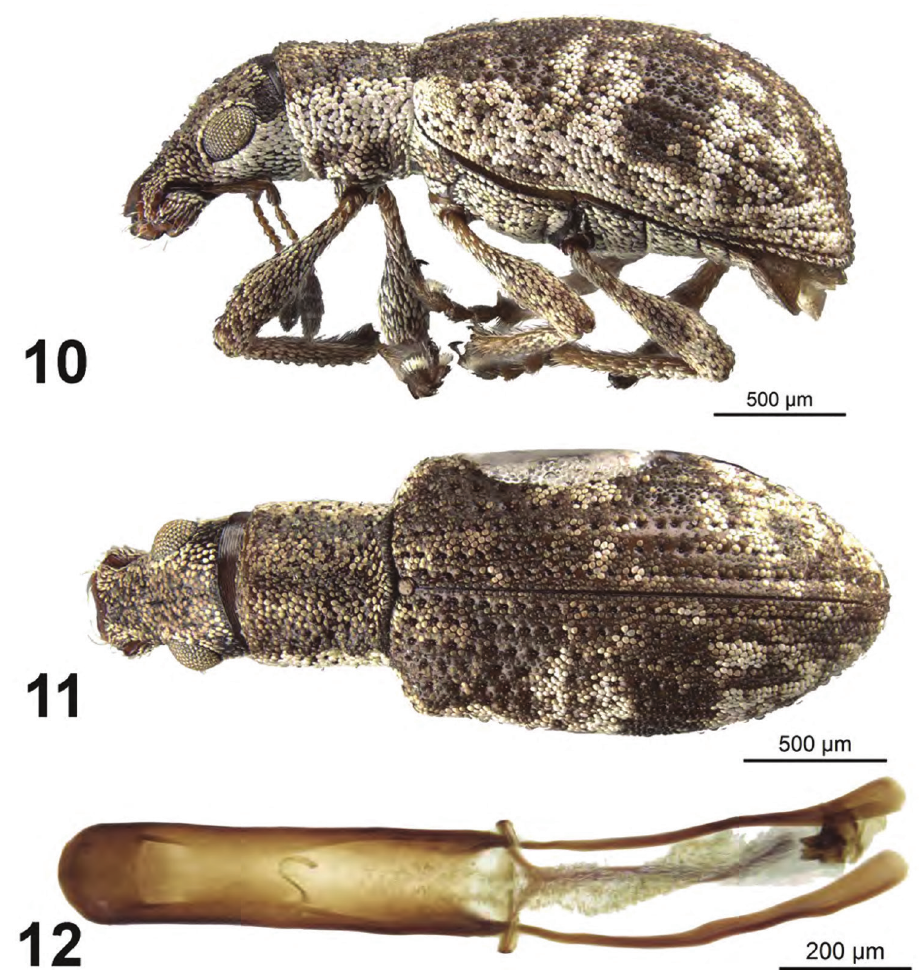
Figures 10–12. Apodrosus franklyni. 10 Lateral habitus, male 11 Dorsal habitus, male 12 Male aedeagus,